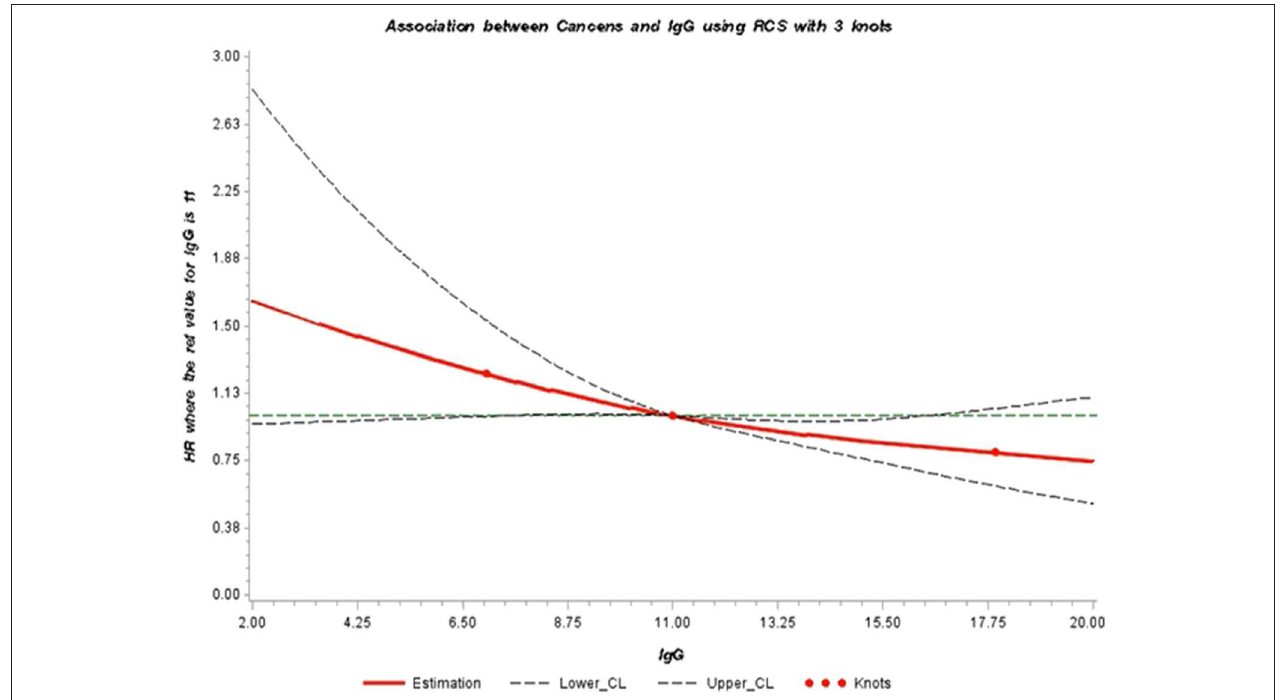
FIGURE 1 | Adjusted dose-response association between serum levels of IgG (g/L) and risk of pancreatic cancer (HR) using restrictive cubic splines. The direction of the hazard ratios observed in Tables 2 , 3 was consistent with the shape of the curve, which presents a positive association for IgG levels lower than 11.00 g/L with pancreatic cancer risk (HR > 1.00) and a protective effect for high levels of IgG (11.00–20.00 g/L) (HR < 1.00). However, the inverse association was only statistically significant for concentrations of IgG between 11.00 and 16.00